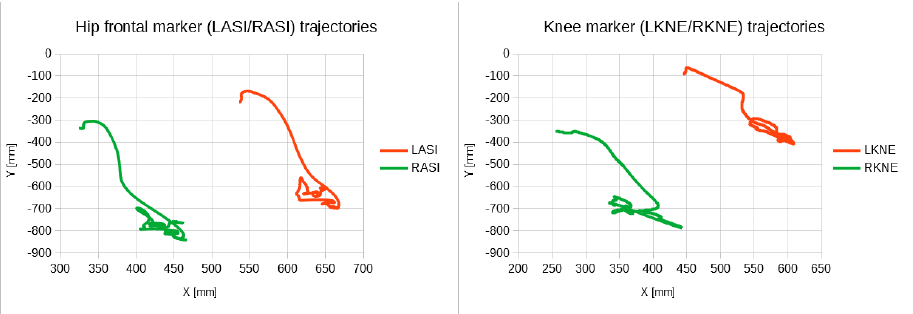
Figure 7. Trajectories for lower body parts for the second sequence.